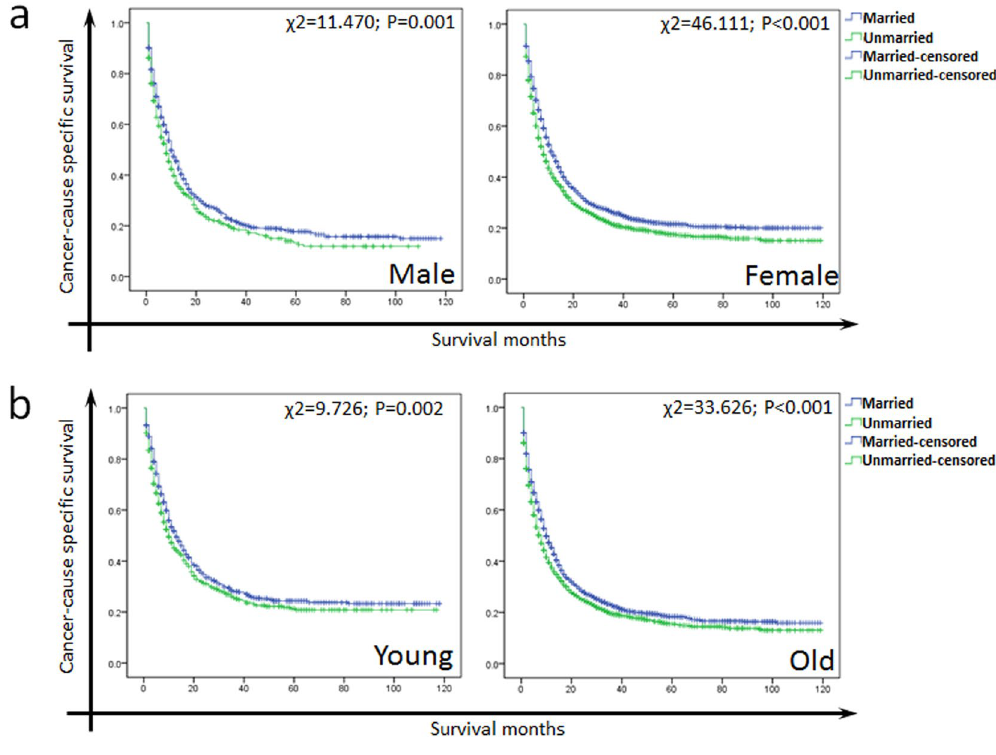
Figure 3. ( a ) The survival curves of male and female GBC patients with different marital status. ( b ) The survival survival curves of young and old GBC patients with different marital status.